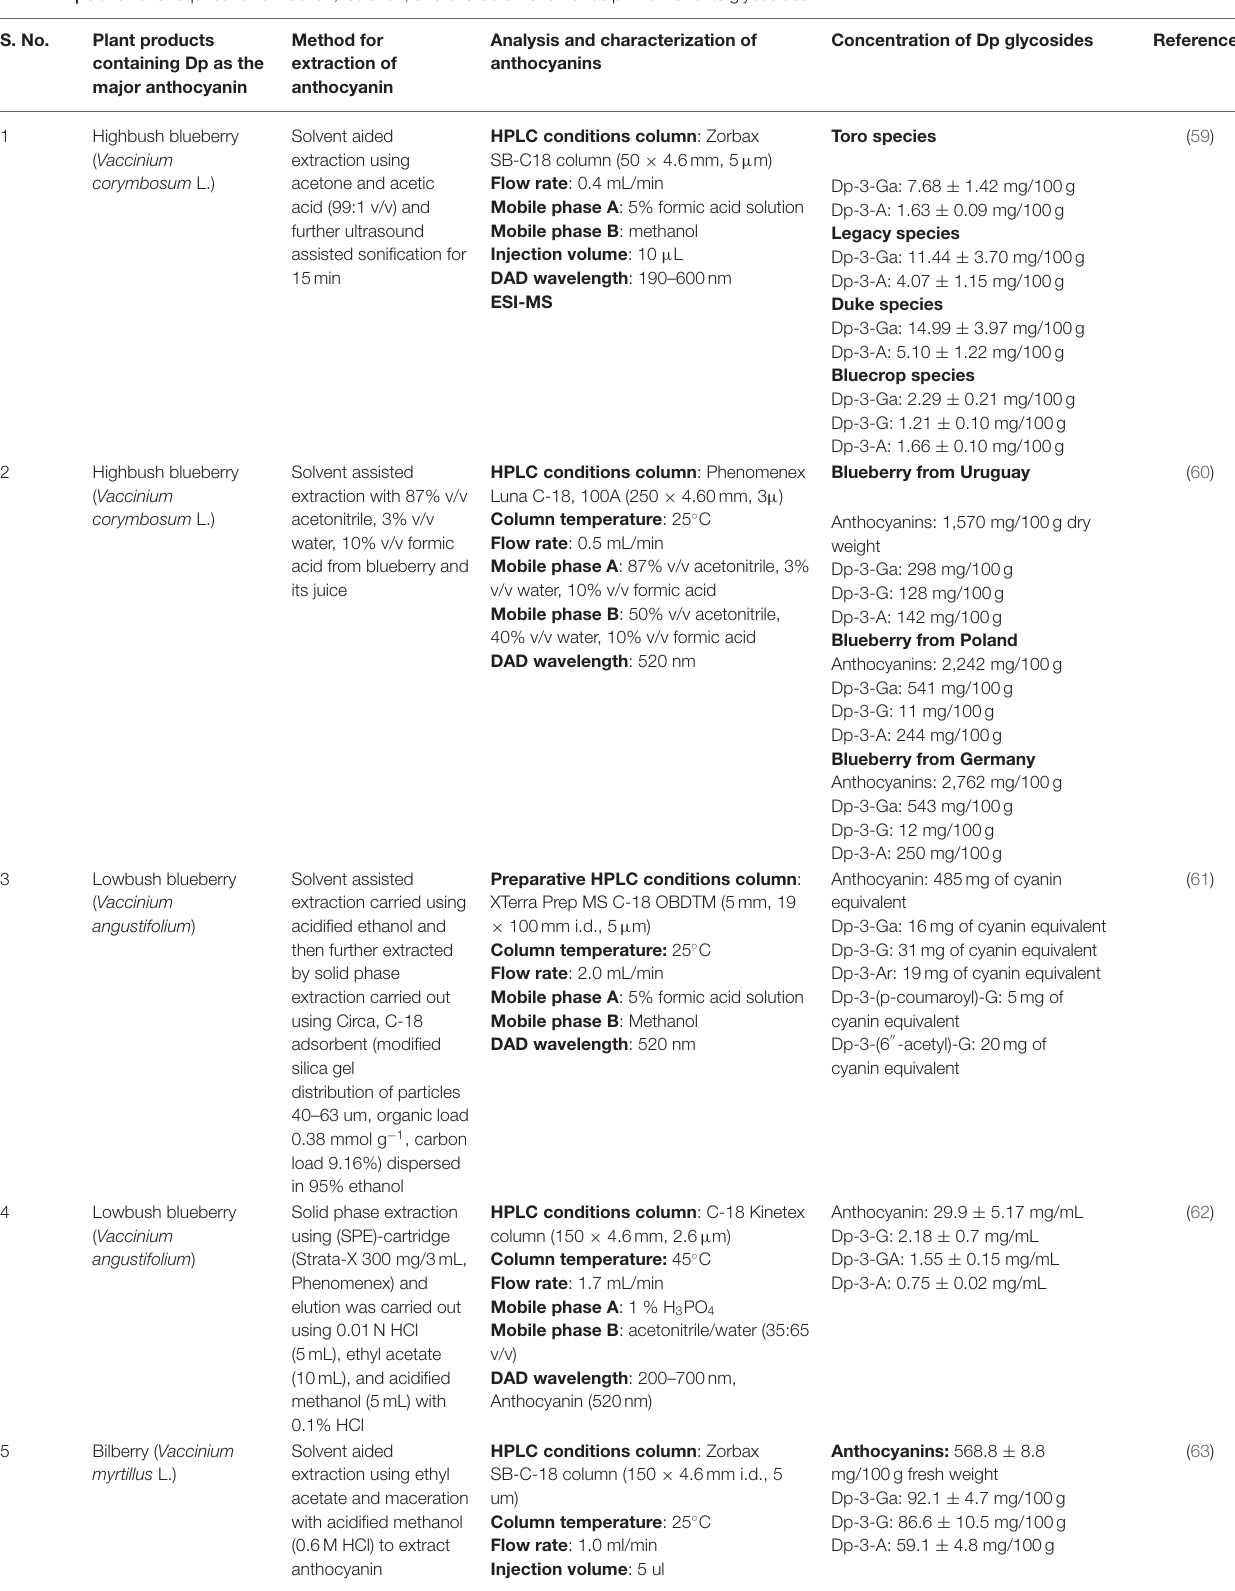
TABLE 1 | Conditions required for extraction, isolation, and characterization of delphinidin and its glycosides. S. No. Plant products containing Dp as